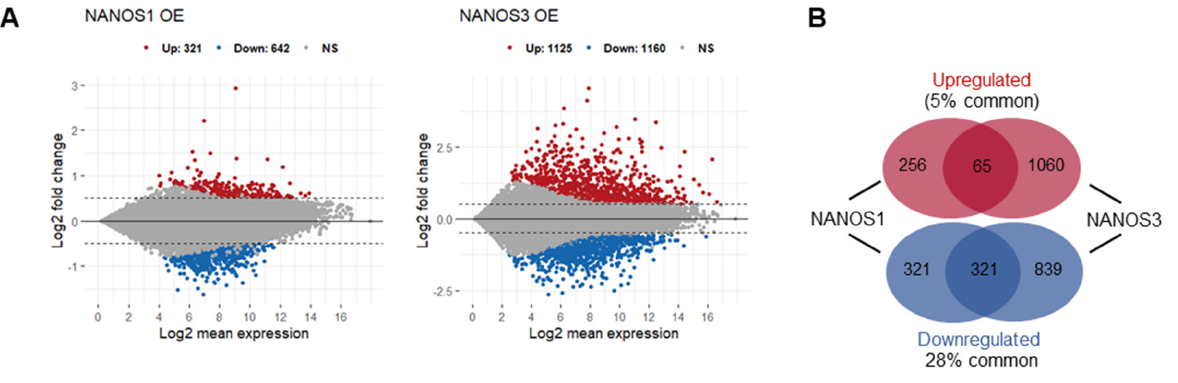
Figure 1. Transcriptomic changes upon NANOS1 and NANOS3 overexpression in TCam-2 cell line. ( A ) RNA-Sequencing (RNA-Seq) upon NANOS1 (left panel) and NANOS3 (right panel) overexpression visualized as MA-plots. Differentially expressed genes were filtered with log2FC ≥